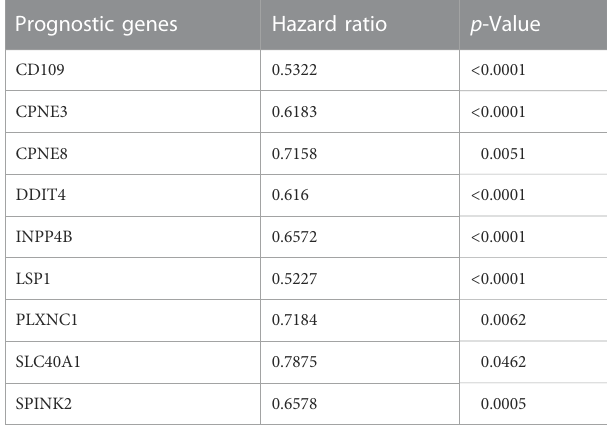
TABLE 3 The estimated hazard ratio of each prognostic gene included in the Cox regression for GSE6891 dataset. Prognostic